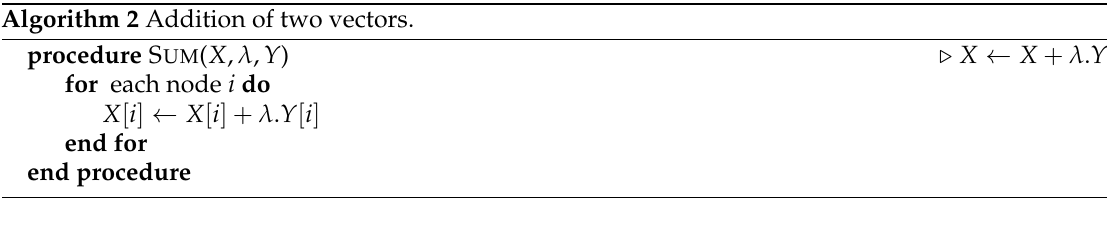
Algorithm 3 Naive dot